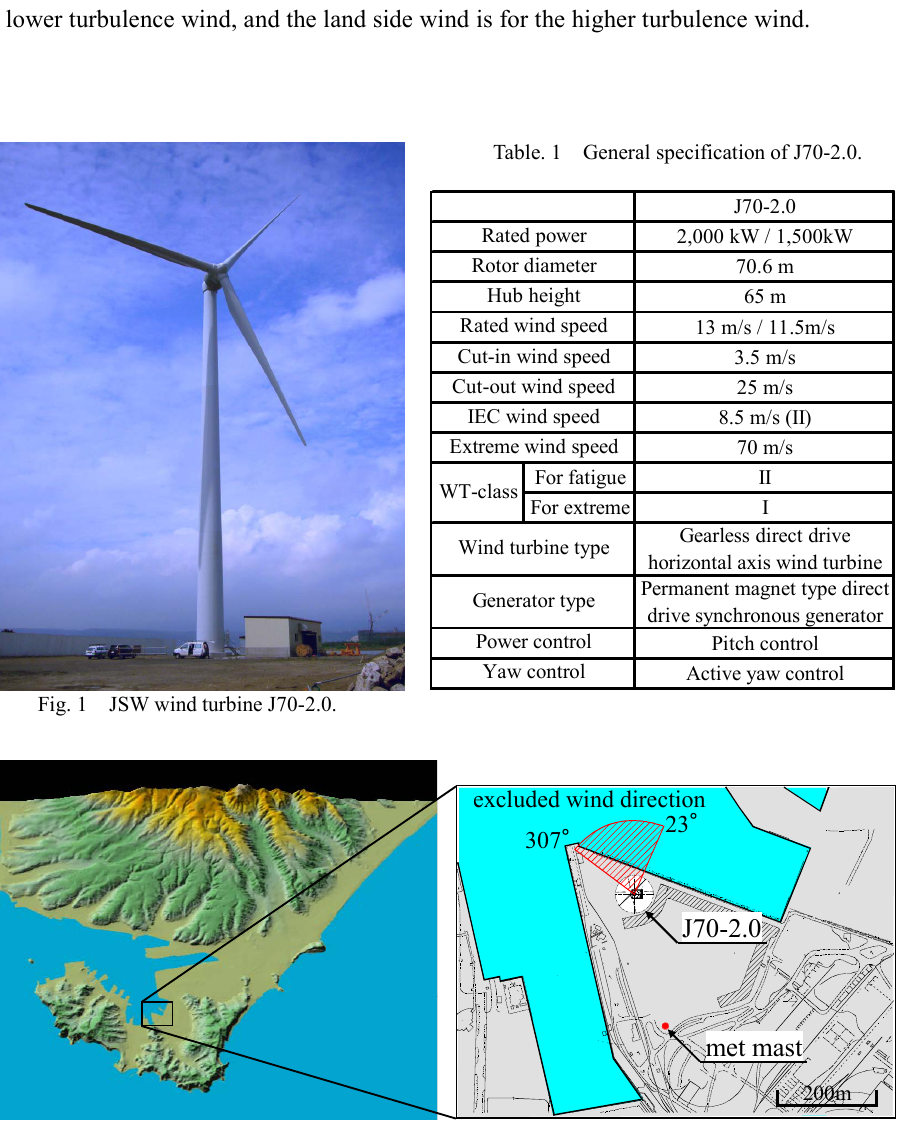
Fig. 2 Measurement sector